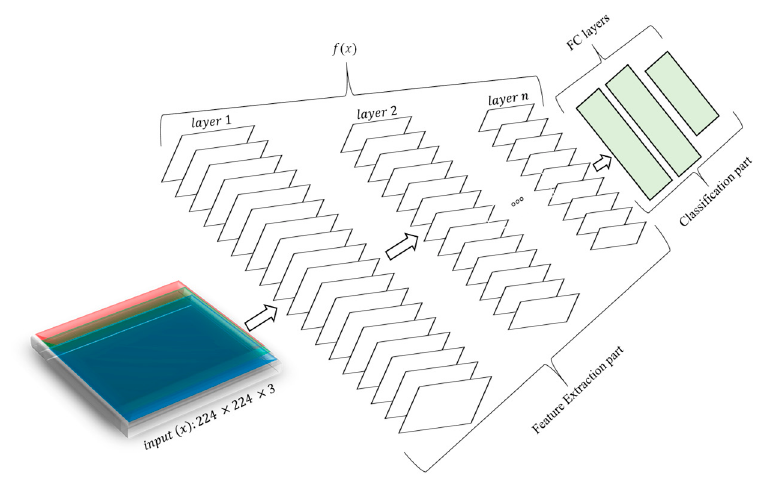
Figure 2. Methodology process.